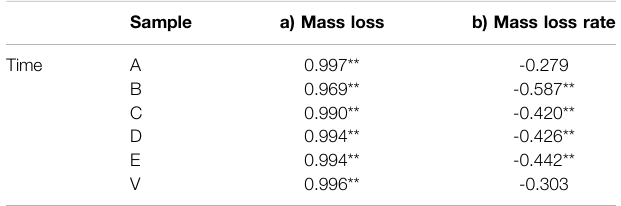
TABLE 3 | Correlations between time and a) mass loss and b) mass loss rate.